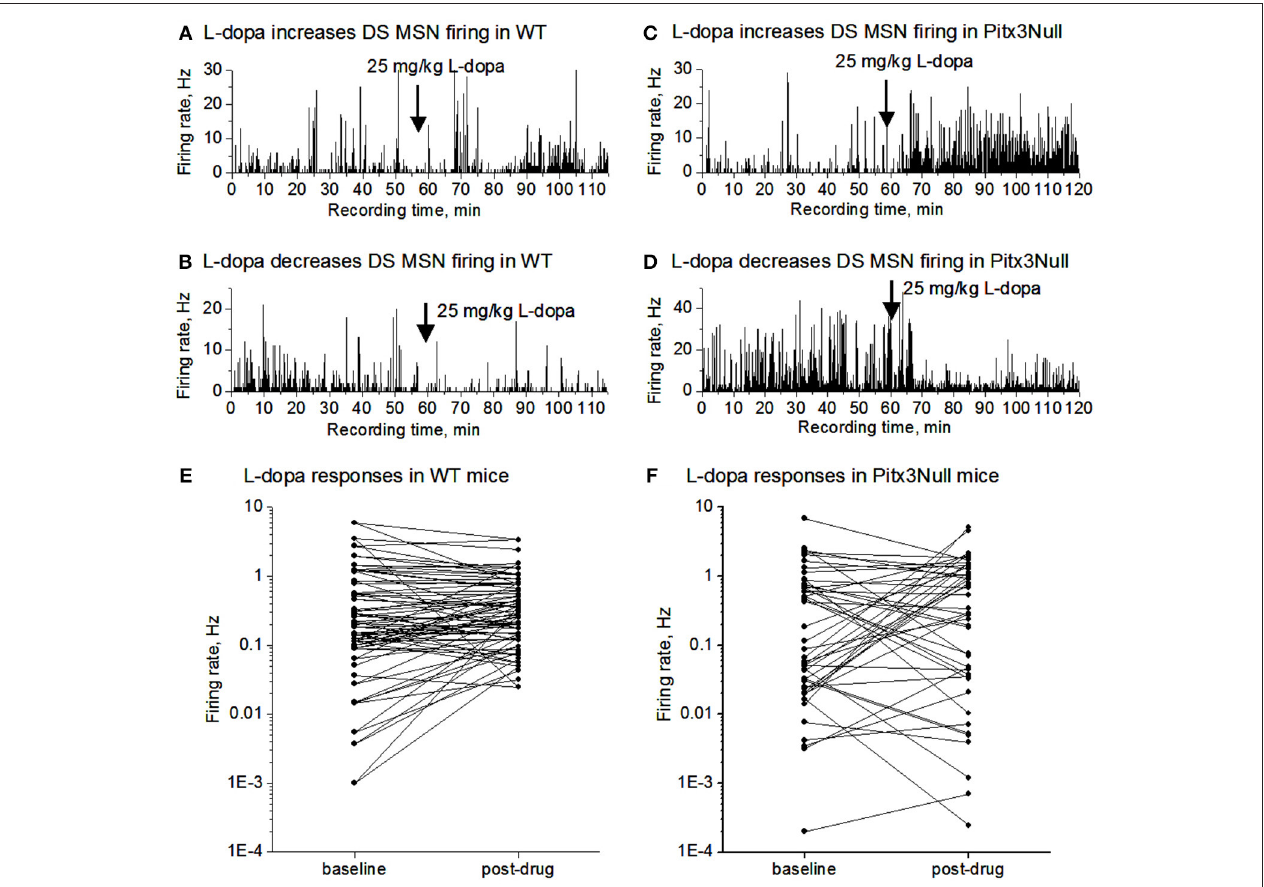
FIGURE 3 | L-dopa effects on the spike firing of mixed MSNs in the dorsal striatum in DA intact WT mice and DA-denervated Pitx3Null mice. (A) L-dopa modestly increased the firing of a MSN in the dorsal striatum in DA-intact WT mouse. (B) L-dopa modestly decreased the firing of a MSN in the dorsal striatum in DA-intact WT mouse. (C) L-dopa strongly increased the firing of a MSN in the dorsal striatum in DA-denervated Pitx3Null mouse. (D) L-dopa strongly decreased the firing of a MSN in the dorsal striatum in DA-denervated Pitx3Null mouse. (E) Paired scatter plot of firing rates before-after L-dopa for all MSNs recorded in the dorsal striatum in Pitx3WT mice. Each dot represents the average firing rate of a single MSN. (F) Paired scatter plot of firing rates before-after L-dopa for all MSNs recorded in the dorsal striatum in Pitx3Null mice. Each dot represents the average firing rate of a single